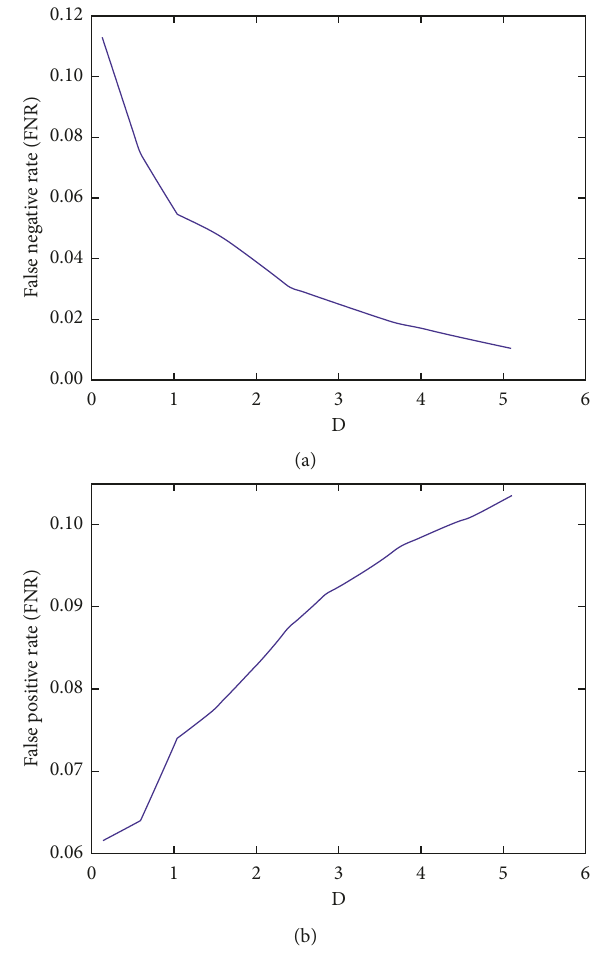
Table 5: Confusion matrix of TN, FN, FP, and TP. Actual